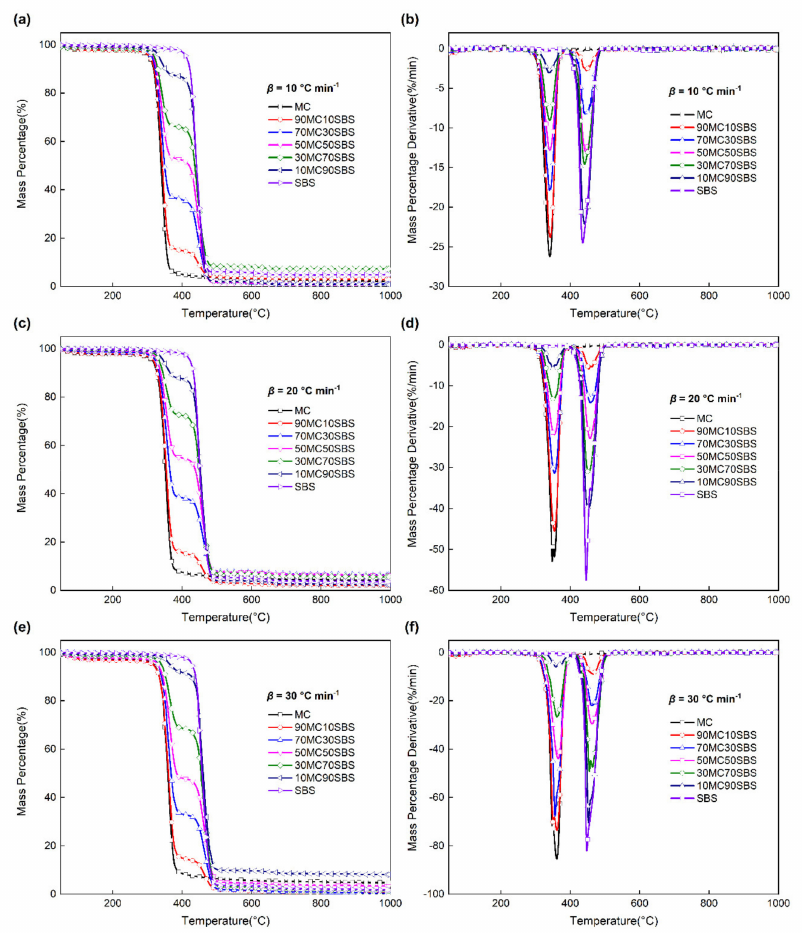
Figure 2. TG and DTG curves of samples with different mixing ratios at heating rates of 10 ( a , b ), 20 ( c , d ), and 30 ( e , f ) ◦ C min − 1 (“XXMCYYSBS” means the mixed sample containing XX% MC and YY%